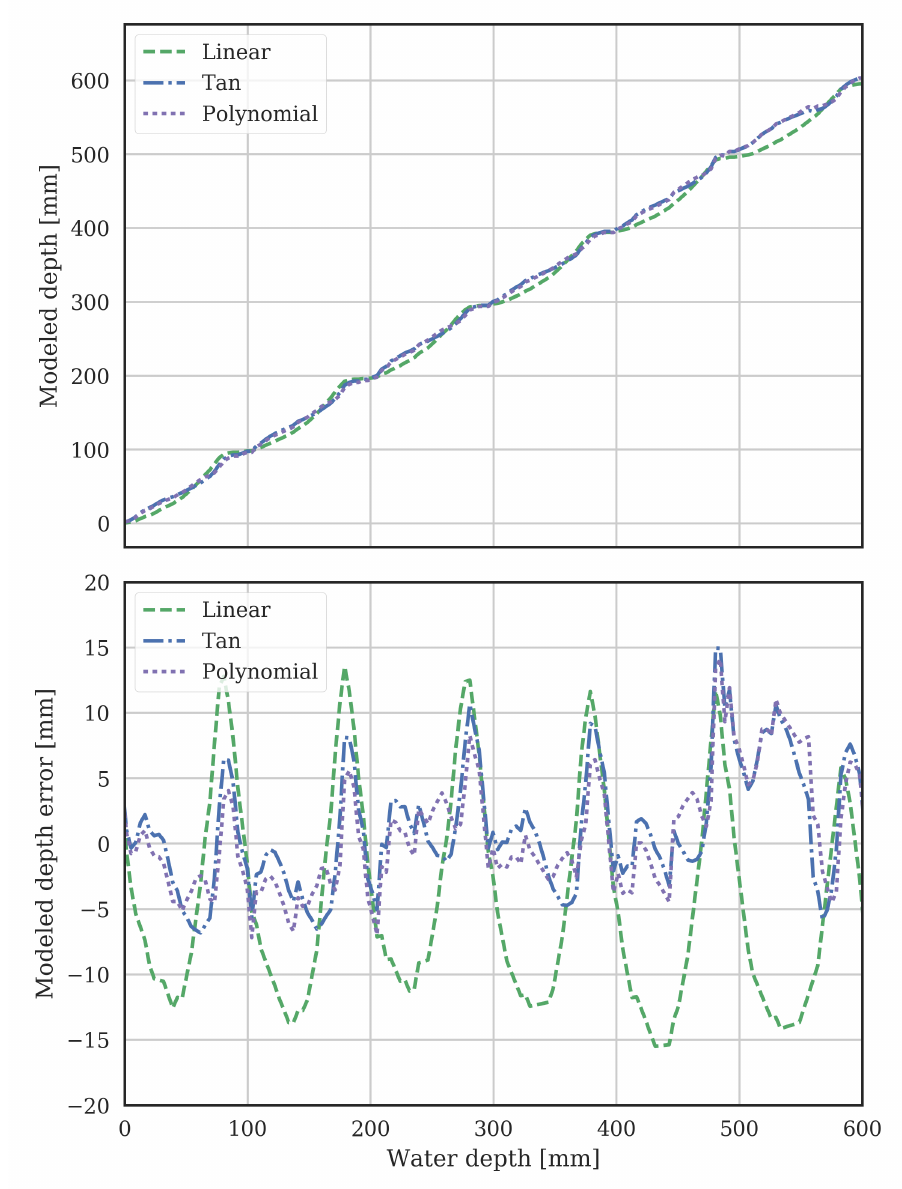
Figure 4. Water depth using the three models processing the characterized MCP’s VWC data, with actual water depth measured by the ultrasonic sensor on the x-axis. The bottom graph shows the error between the actual (ultrasonic) and modeled (MCP)